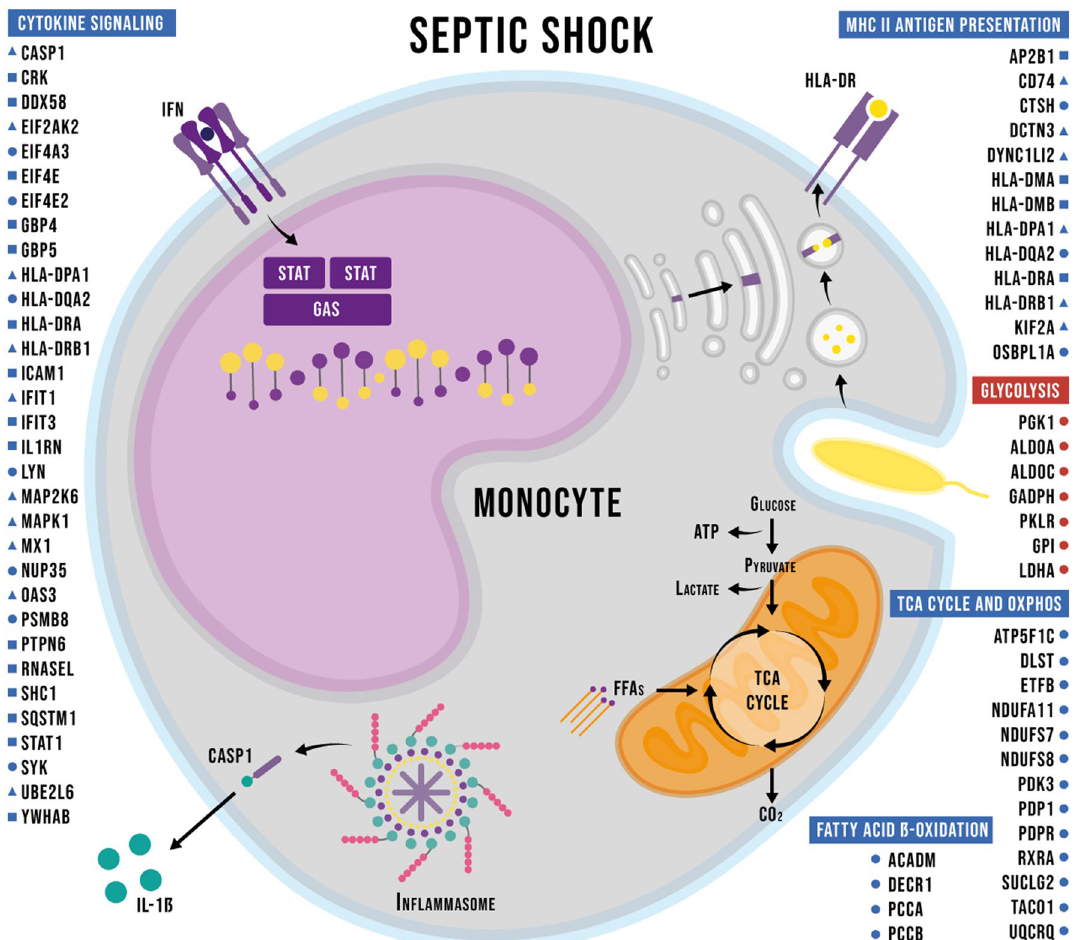
Figure 4. Graphical summary of the main findings regarding the immunometabolic phenotype. Proteins of selected enriched Reactome pathways are listed. Adjacent symbols indicate up (red) or down (blue)-regulation in the comparisons between Sepsis and Control (circles), Sepsis end Recovery (squares), or both comparisons